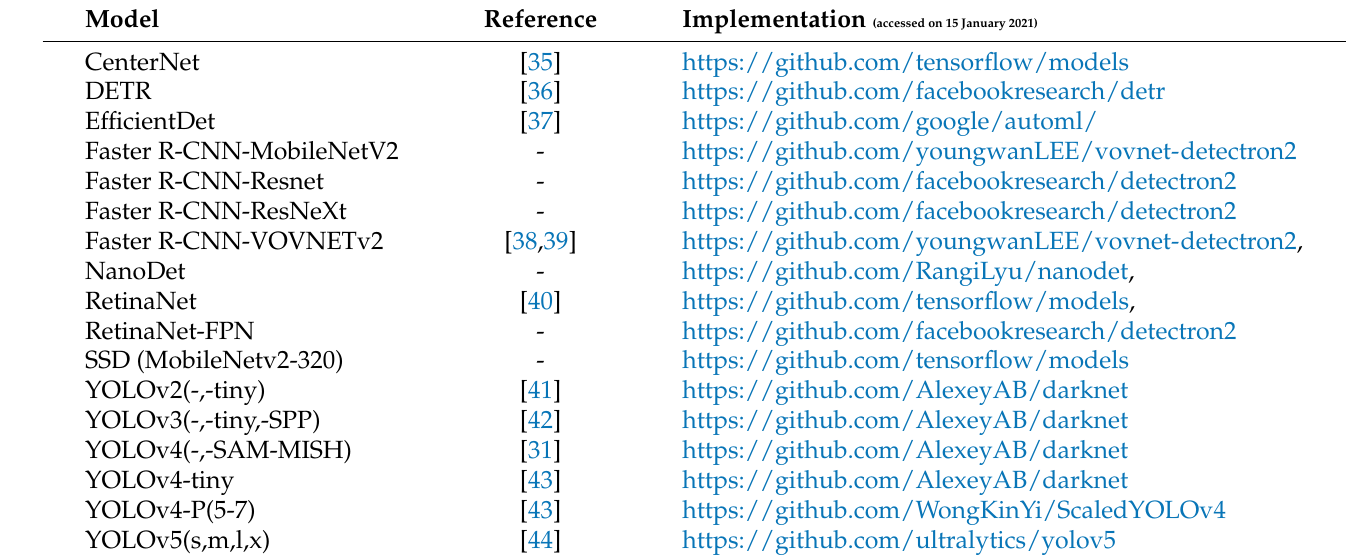
Table 1. Models selected for